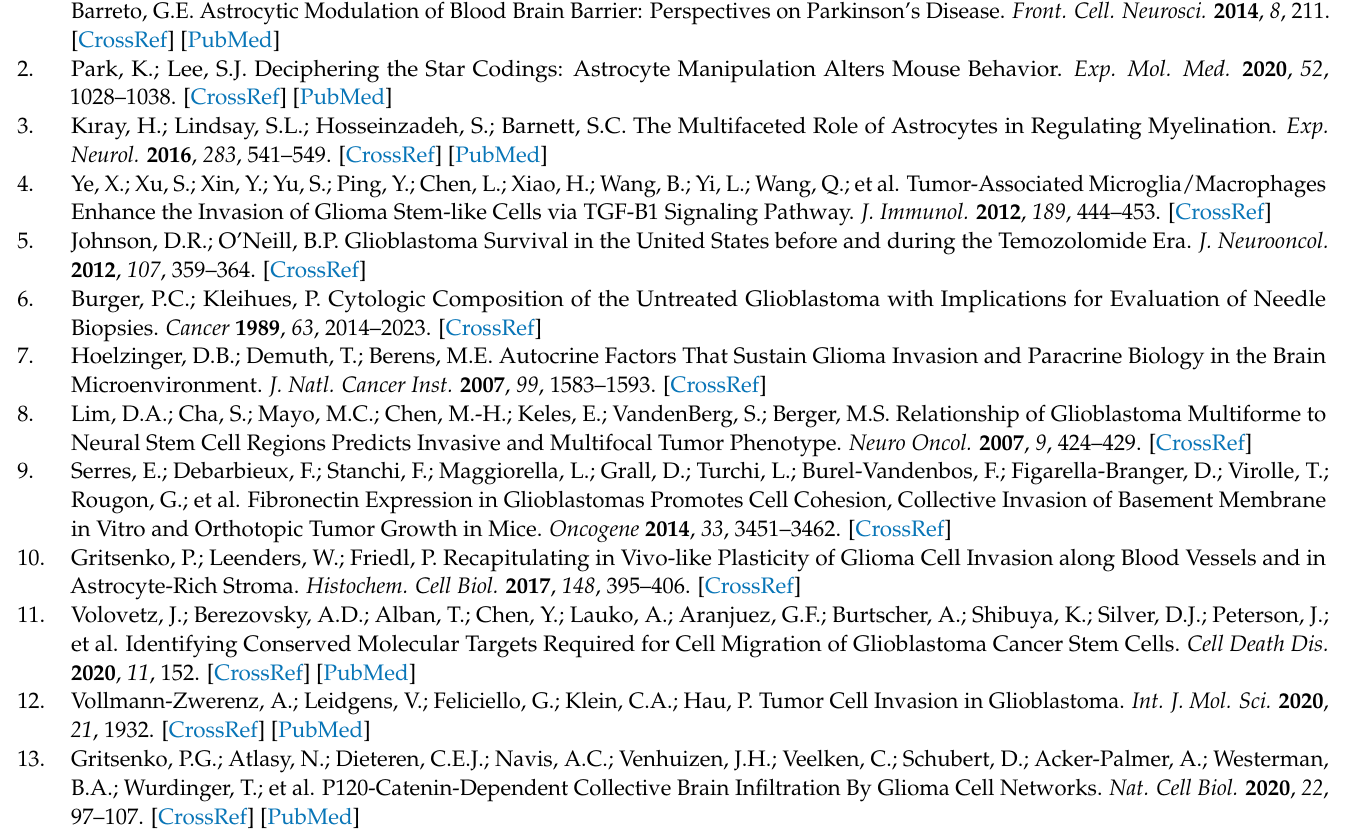
the ROCK inhibitor Y-27632 or myosin II inhibitor blebbistatin; Figure S13: Experimental setup